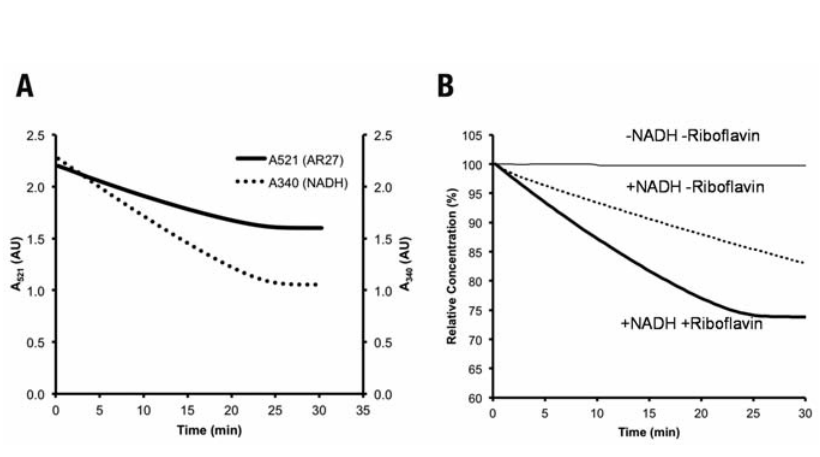
Figure 3. A) Reduction of AR27 by Fre and the simultaneous oxidation of nicotinamide adenine dinucleotide (NADH); B) Reduction of AR27 by Fre in the presence of NADH and/or